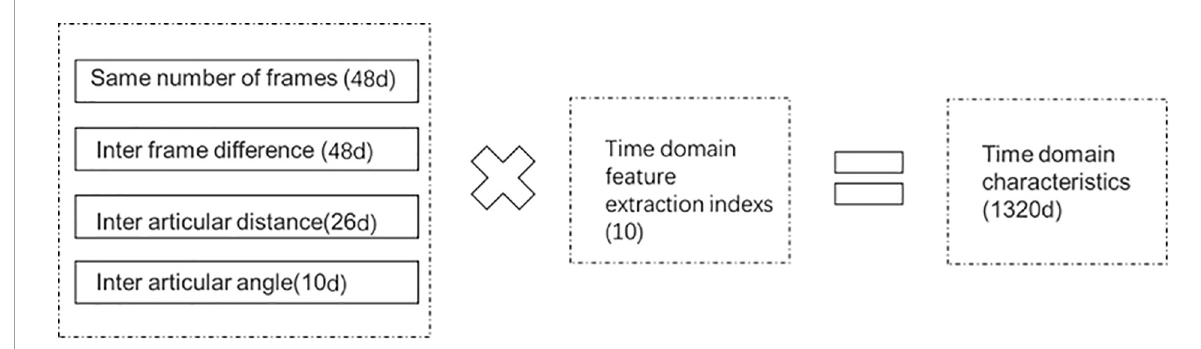
FIGURE3 Illustration of time characteristic dimension.